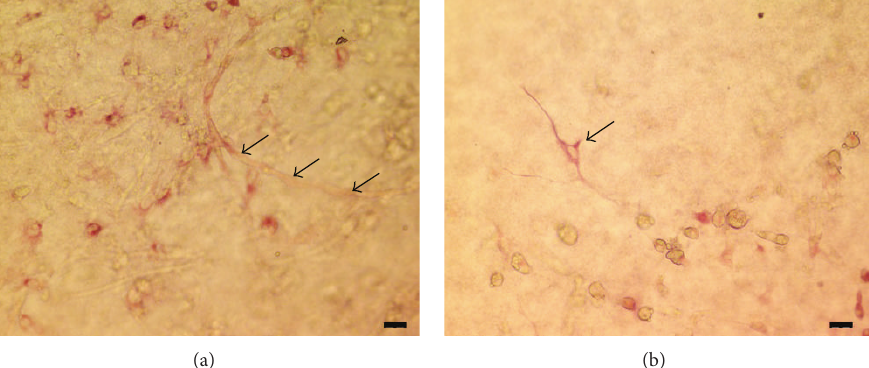
Figure 10: (a) Cell-cell adhesion was diminished, and many CD133-positive cells adopted a round morphology. Arrows indicated the degradation of capillary tubes. Scale bar = 20 𝜇 m. (b) Some polygonal cells with cell processes maintained their morphology (arrow). Scale bar = 20 𝜇 m.